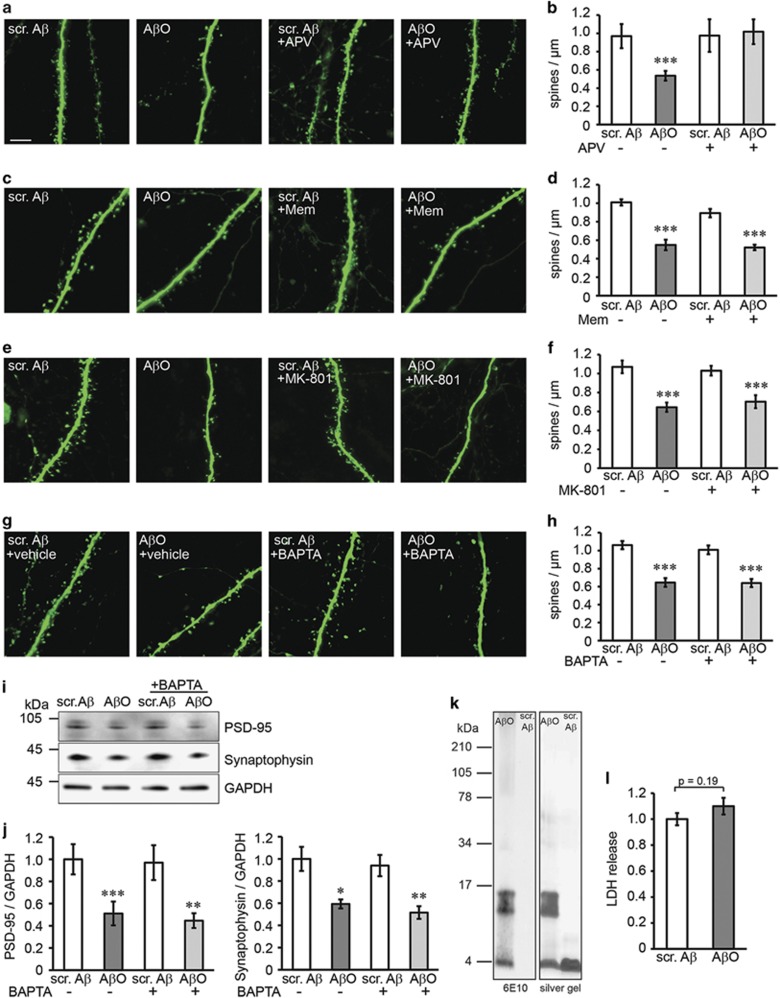
Oligomeric Aβ-induced synaptic loss is prevented by APV but not by memantine, MK-801 or BAPTA treatment. (a) Confocal images of dendrites from CA1 neurons in the stratum radiatum of non-transgenic slice cultures treated with oligomeric Aβ (500 nM) or scrambled Aβ (500 nM) and NMDAR antagonist APV (100 μM). Scale bar: 5 μM. (b) APV treatment prevents Aβ oligomer-induced dendritic spine loss. n=13–17. (c) Confocal images of non-transgenic cultures treated with oligomeric Aβ (500 nM) and NMDAR antagonist memantine (1 μM). (d) Memantine treatment does not prevent spine loss. n=12–17. (e) Confocal images of cultures treated with oligomeric Aβ (500 nM) and NMDAR antagonist MK-801 (30 μM). (f) MK-801 treatment does not prevent spine loss. n=13–15. (g) Non-transgenic cultures treated with Aβ oligomers (500 nM) and Ca2+ chelator BAPTA (2 mM) or vehicle (BAPTA solvent NaHCO3). (h) BAPTA does not prevent spine loss caused by oligomeric Aβ. n=11–15. (i) Representative western blot of cell lysates from slices after treatment with Aβ oligomers (500 nM) and Ca2+ chelator BAPTA (2 mM). (j) BAPTA does not prevent reduction in PSD-95 or synaptophysin levels after Aβ oligomer treatment. n=6. (k) SDS gel showing oligomeric Aβ preparations and scrambled Aβ after silver staining (right panel) and western blot stained with 6E10 antibody (left panel). Monomers, tri- and tetramers are observed in the oligomeric preparation, whereas scrambled Aβ only shows monomers. (l) LDH assay showing no toxicity of Aβ oligomer treatment (500 nM) compared with scrambled Aβ. n=6. Values are shown as mean±S.E.M. (*P<0.05, **P<0.01, ***P<0.001; two-tailed unpaired Student's t-test). Scr. Aβ, scrambled Aβ; AβO, oligomeric Aβ; Mem, memantine